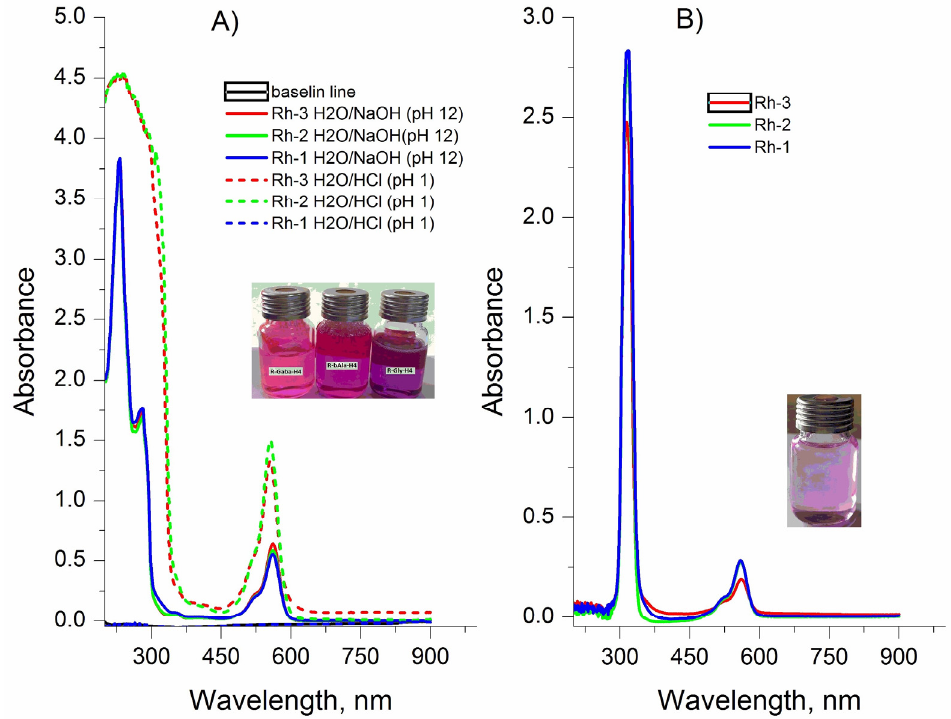
Figure 4. UV-Vis spectrum of Rhodamine derivatives at: ( A ) equal concentration of the compounds and different pH of solutions. Absorbance of the solution was measured against water; ( B ) solutions of Rh-1, Rh-2 and Rh-3 in triethylamine with equal concentration of the compounds. Absorbance of the solution was measured against triethylamine.